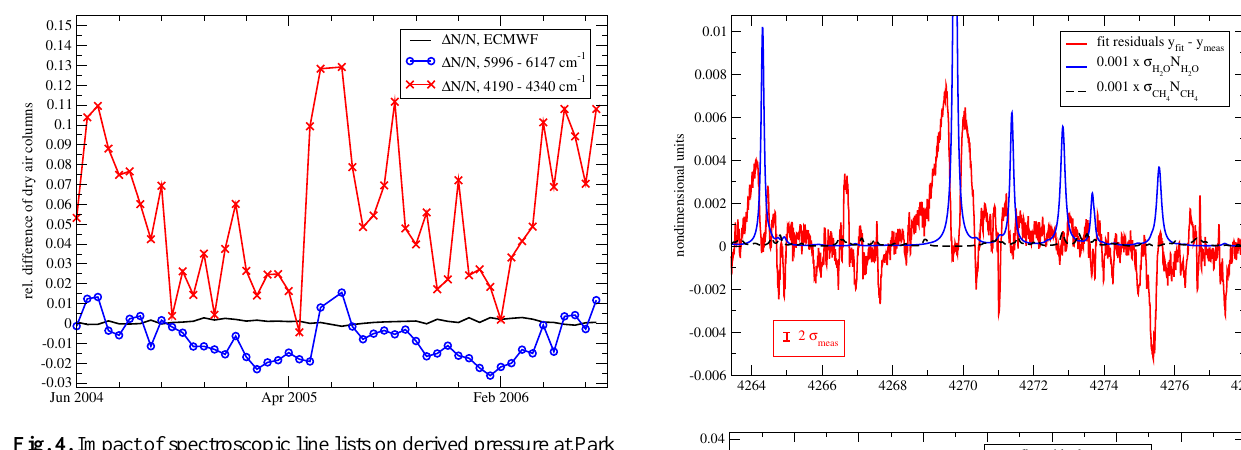
Fig. 4. Impact of spectroscopic line lists on derived pressure at Park Falls. Black: total dry air column for fixed ECMWF pressure profile, plotted as relative difference to in-situ measurement. Circles: dry air column derived from 5996–6145cm − 1 , crosses: dry air column derived from 4190–4340cm − 1 .